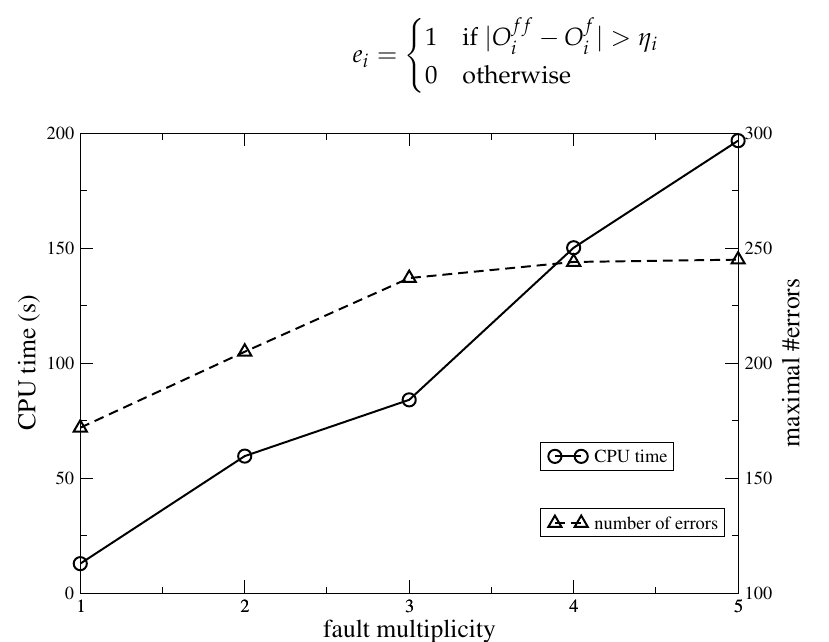
Figure 9. CPU time used by a PB-SAT optimizer to maximize the number of errors as a function of the maximal allowed number of faulty cells.